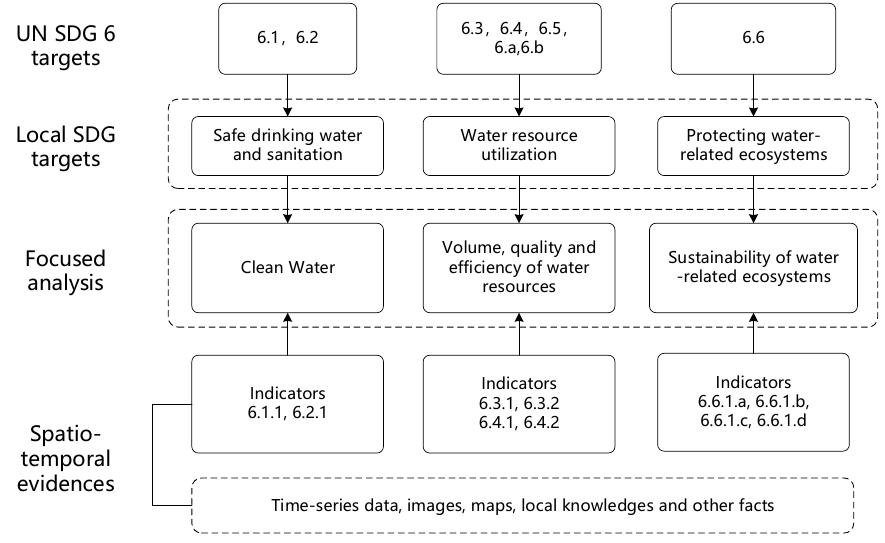
Figure 6. Assessment of local SDG 6 with spatiotemporal evidence.